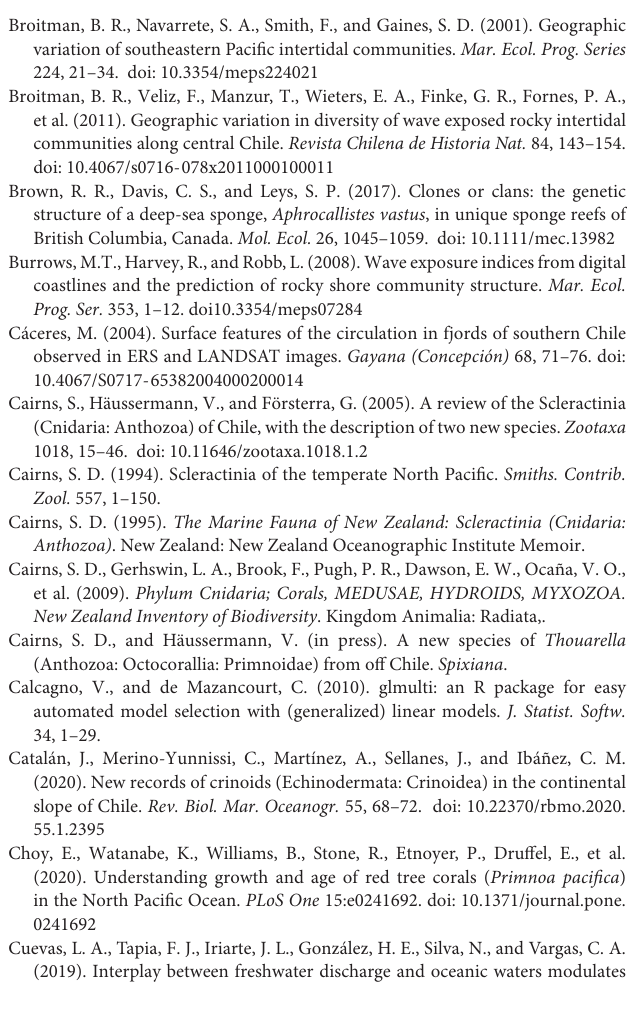
Supplementary Figure 2 | Relationship between each variable and presence probability calculated during GLM analysis (A) complete dataset. (B) < 50 m; (C) > 200 m. Supplementary Figure 3 | Spatial variation of mean Chlorophyll-a concentration at different depths. (A) surface and (B) bottom waters. Supplementary Figure 4 | Spatial variation of mean temperature at different depths. (A) Surface and (B) bottom waters. Supplementary Figure 5 | Spatial variation of mean salinity at different depths. (A) surface and (B) bottom waters. Supplementary Figure 6 | Spatial variation of mean dissolved molecular oxygen concentration at different depths. (A) Bottom and (B) Surface waters. Supplementary Figure 7 | Spatial variation of silica concentration at different depths. (A) Surface and (B) bottom waters. Supplementary Figure 8 | Latitudinal variation of parameters along the Chilean coast (18–56 ◦ S) at two depths. The blue line represents surface water while the orange line represents deep water ( > 200 m). The points are the mean for each latitudinal band while the whiskers represent minimum and maximum values at each latitudinal band. (A) oxygen, (B) salinity, (C) silica, (D) temperature, (E) primary production, (F) chlorophyll a . (G) current velocity. Supplementary Figure 9 | Turbidity (Kd_490) for Chilean Patagonia based on southern hemisphere winter average for Kd_490 for the year 2009, as derived